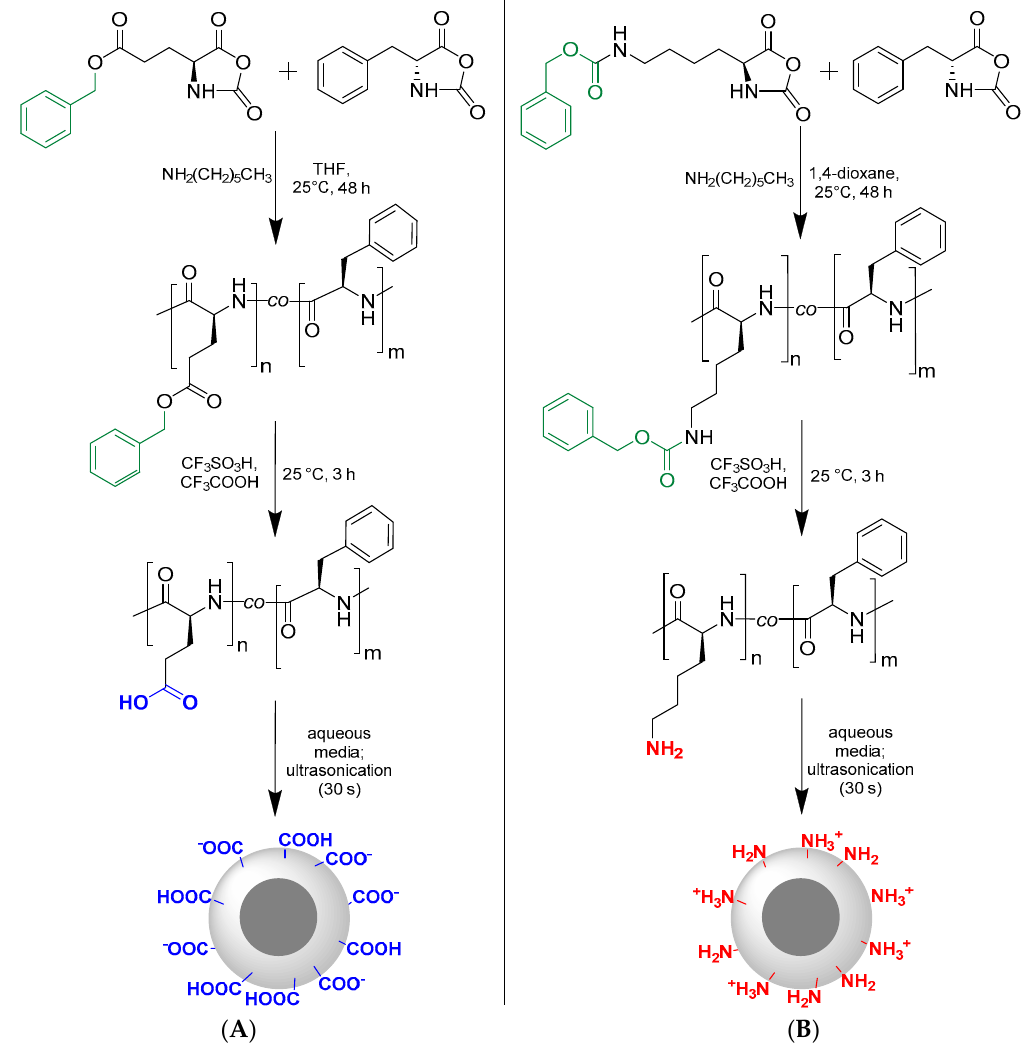
Figure 1. Scheme of polymerization and preparation of self-assembled nanospheres: ( A ) P(Glu- co - D Phe); ( B ) P(Lys- co - D Phe). Table 1. Monomer ratios, polymer yields and characteristics of synthesized protected copolymers.